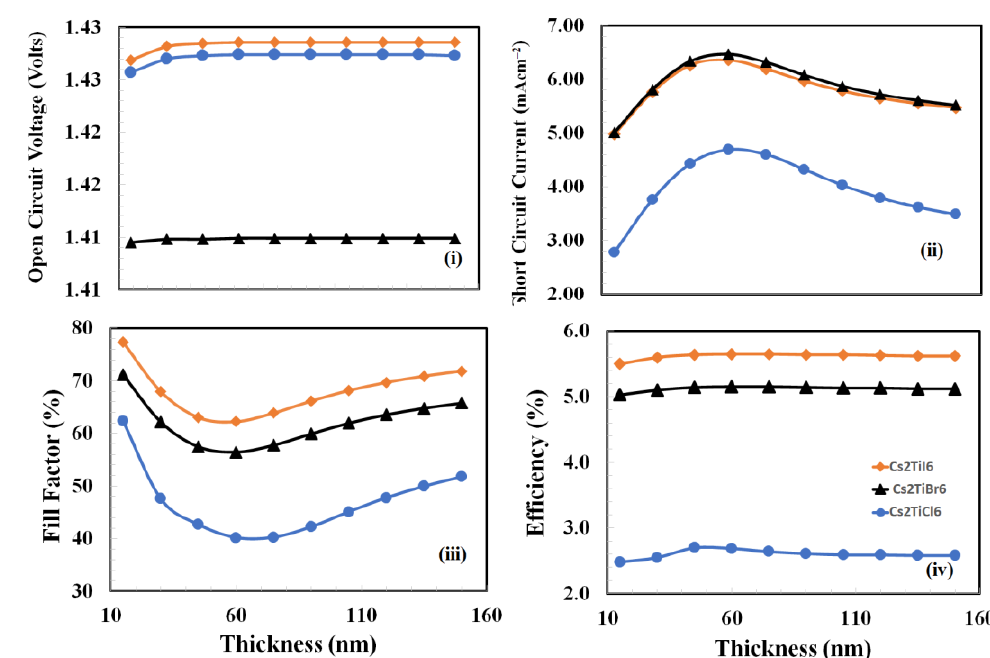
Figure 3. The photovoltaic response parameters: ( i ) open-circuit voltage, ( ii ) short-circuit current, ( iii ) fill-factor, and ( iv ) power-conversion efficiency, as a function of the thickness of PEDOT:PSS thin film (hole-transport layer) for the proposed devices Cs 2 TiCl 6 , Cs 2 TiBr 6 , and Cs 2 TiI 6 respectively.